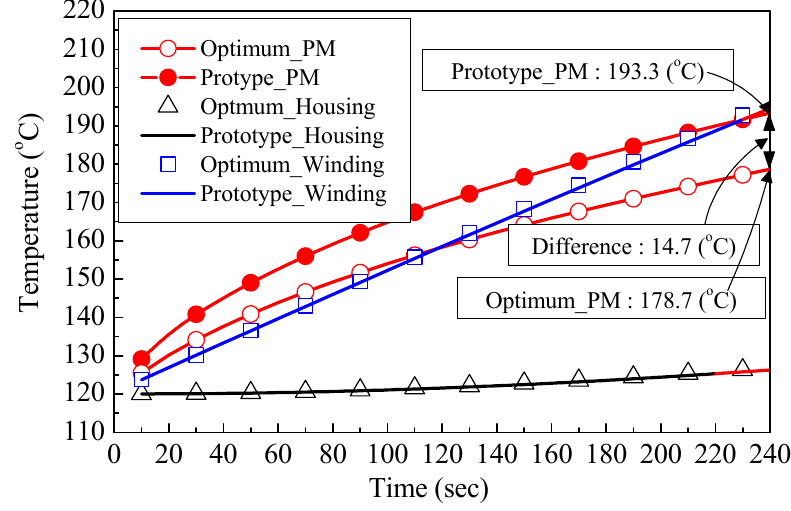
Figure 12. Analysis results from thermal equivalent circuit.